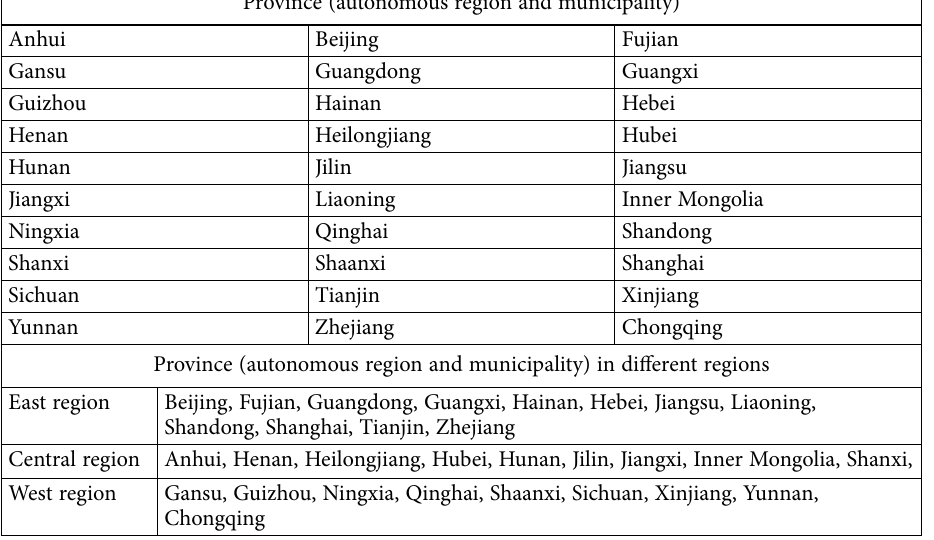
Table A2. List of sample